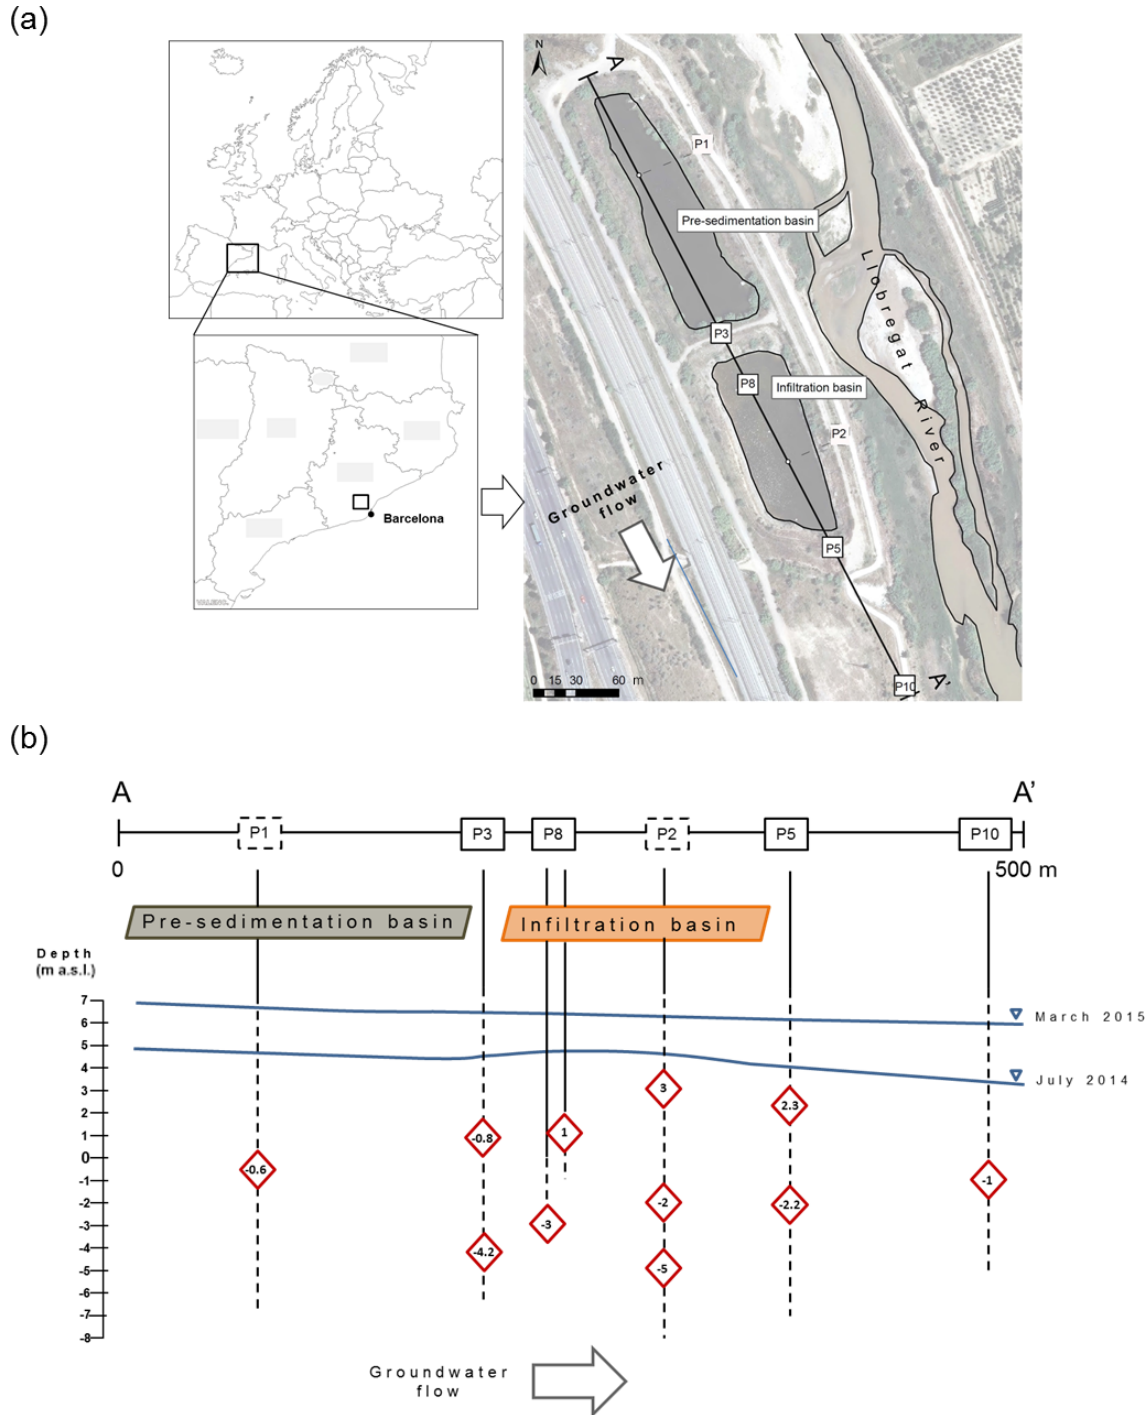
Figure 1. Geographical location of the Llobregat MAR system and location of the established transect. (a) Transect section with piezometers (P1 and P2 are projected) and displaying sampling depths (red diamonds). (b) Blue line shows groundwater level in July 2014 (wet scenario – recharge) and March 2015 (dry scenario –